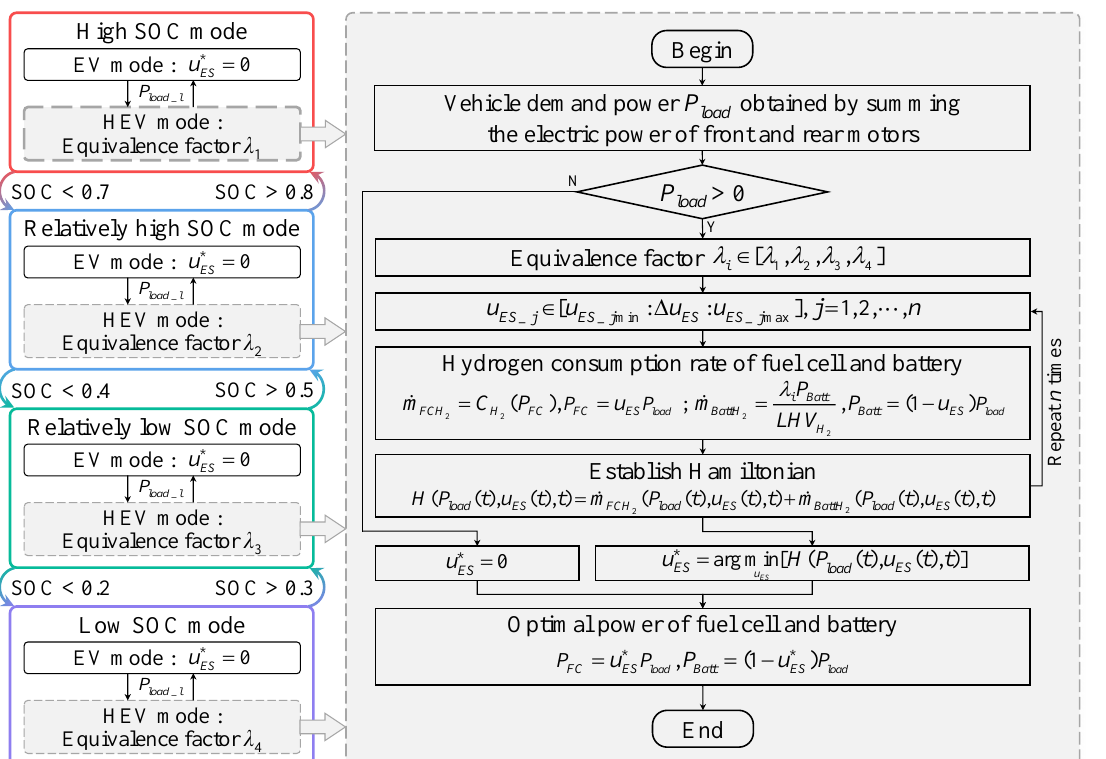
where P FC ( t ) and P Batt ( t ) are the power of the fuel cell system and the battery at moment t , respectively; u ES ( t ) is the power distribution coefficient between the fuel cell system and the battery; λ i is the equivalent factor for converting the battery electrical energy consumption rate into hydrogen consumption rate and λ i ∈ [ λ 1 , λ 2 , λ 3 , λ 4 ] . Note that λ 1 , λ 2 , λ 3 and λ 4 correspond to the levels of high SOC, relatively high SOC, relatively low SOC, and low SOC, respectively. In the A-ECMS control framework, the dragonfly algorithm is employed to perform an iterative optimization search on the equivalent factor vector [ λ ] 1 , λ 2 , λ 3 , λ 4